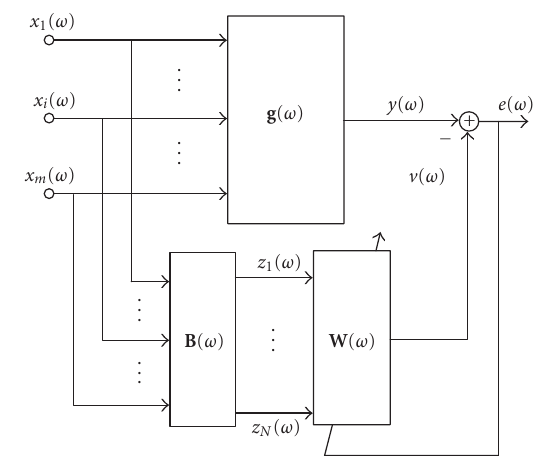
Figure 1: Schematic of MF-GSC in frequency domain. then used to produce the reference signal u ( m , ω ) with higher SNR for ASV